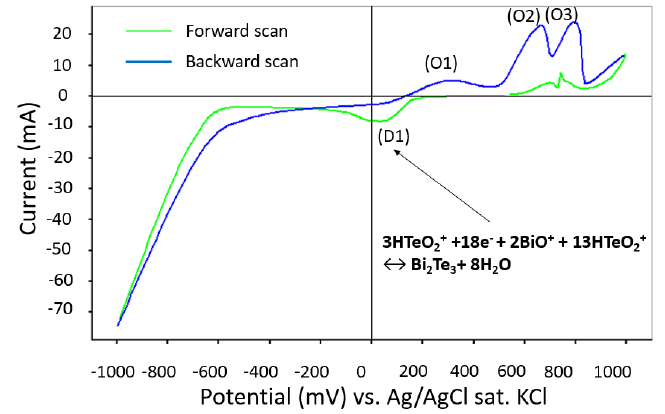
Figure 2. Cyclic voltammetry for BiTe deposition.